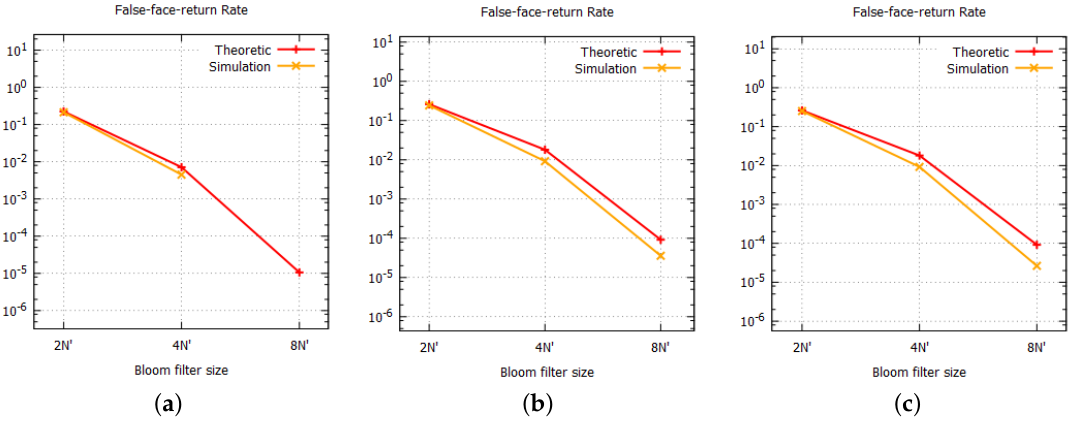
Figure 7. Comparison of false face return rate for p -BF: ( a ) 10k; ( b ) 50k; ( c )